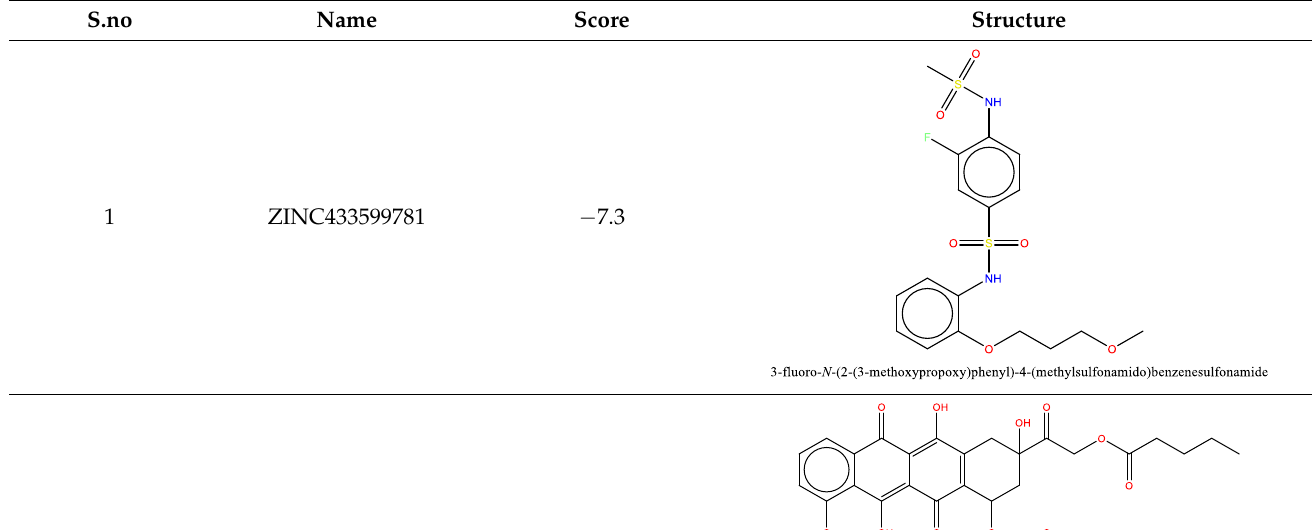
Table 3. Summary of the four shortlisted compounds with binding energy kcal/mol.